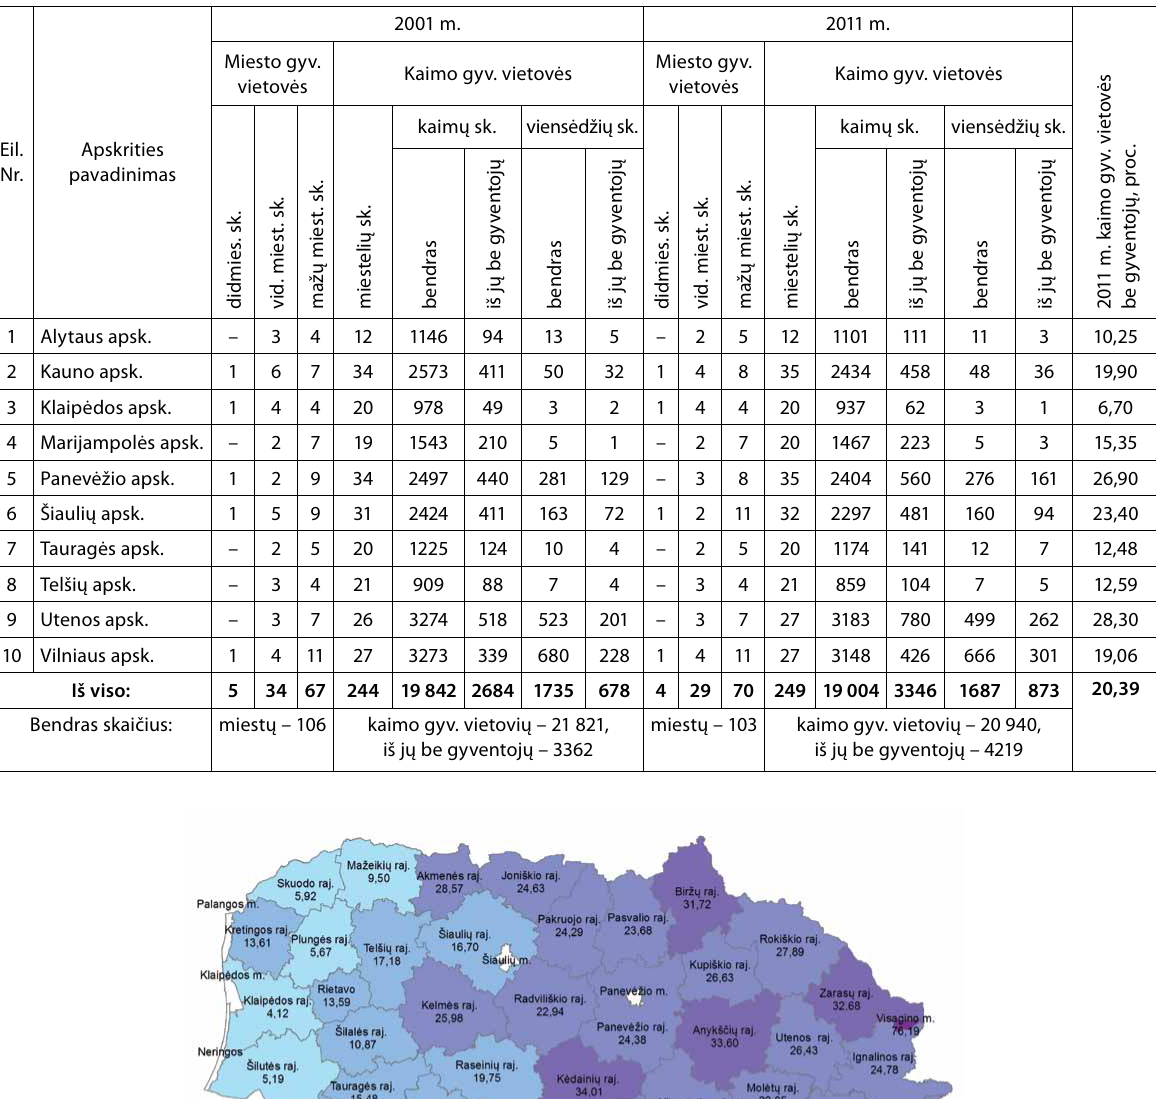
apskrities pavadinimas